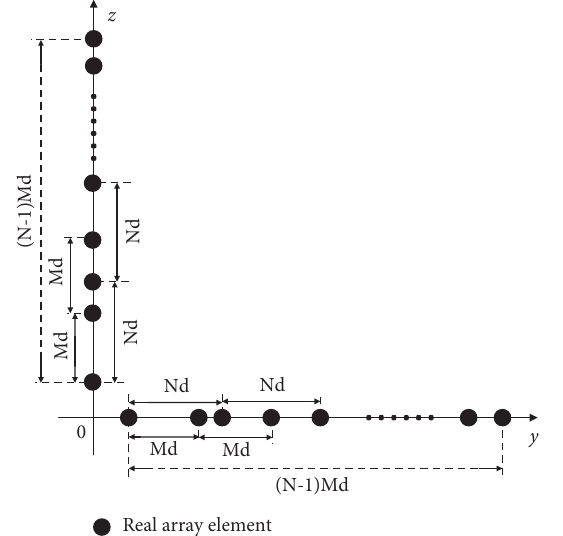
Figure 5: The schematic diagram of the L-shaped array structure.